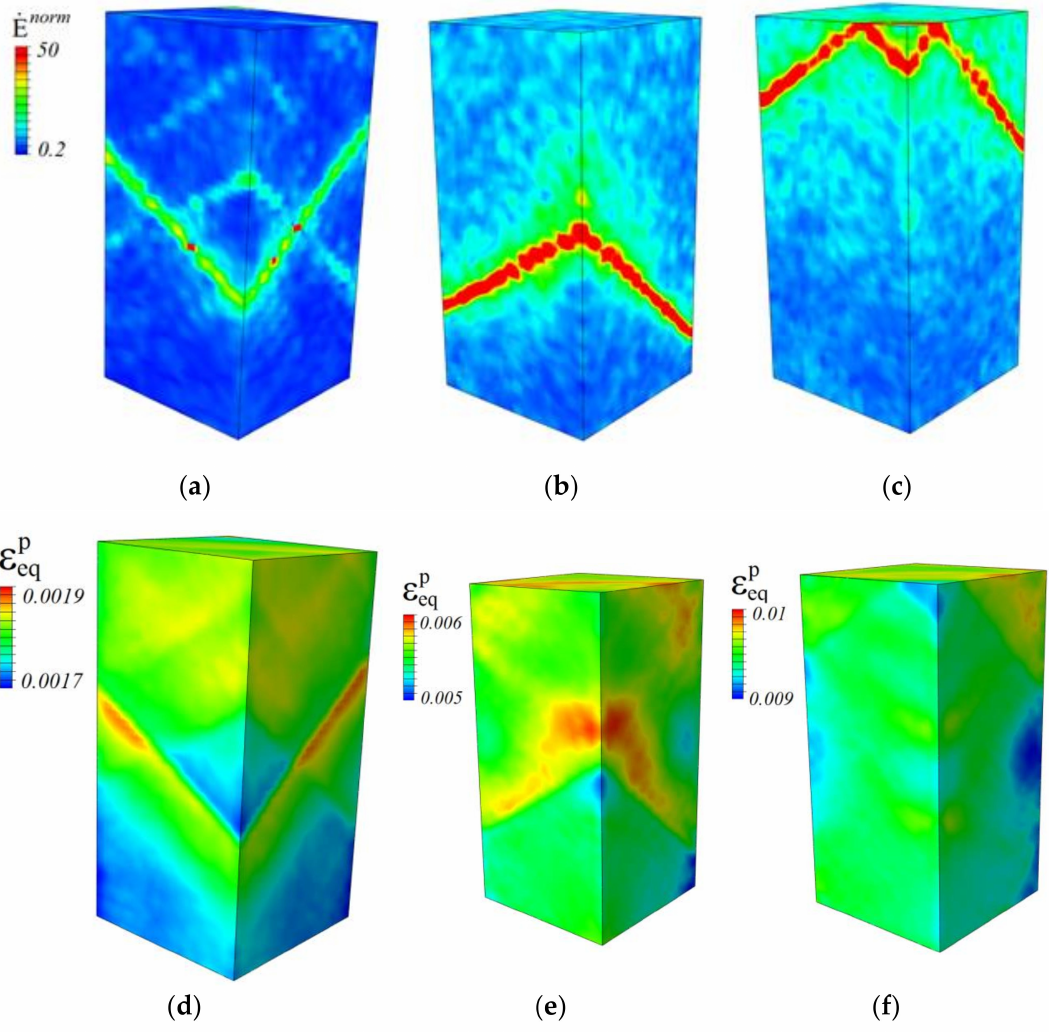
Figure 8. Normalized strain rate ( a – c ) and equivalent plastic strain fields ( d – f ) in the crystal with (cid:0) (cid:1) (cid:0) (cid:1) 112 and 111 lateral faces in the initial stage of compression along the [110] axis for compressive strains of 0.002 ( a , d ), 0.005 ( b , e ), and 0.008 ( c , f